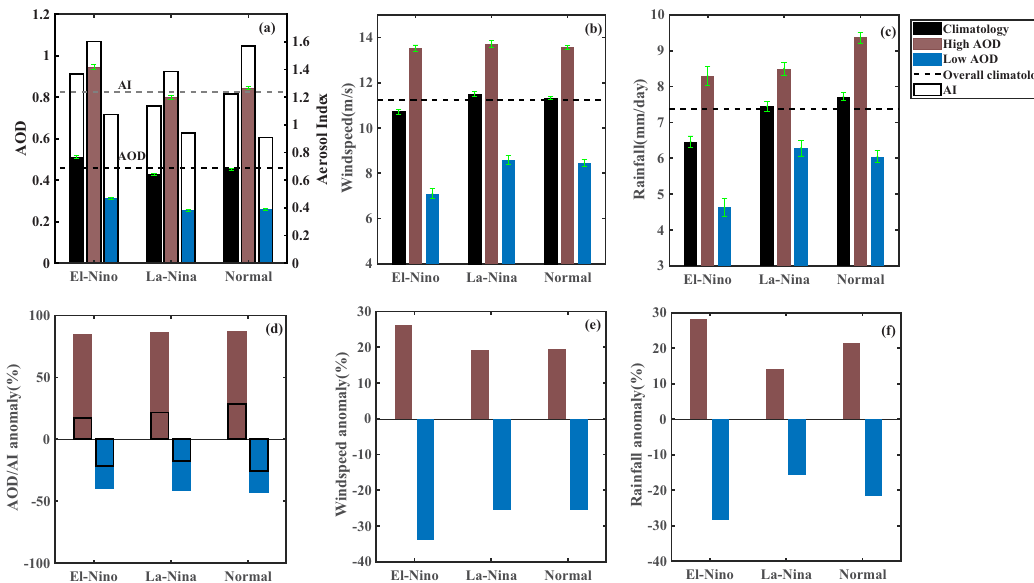
Fig. 3 Response of AOD/AI, winds over AS and rainfall over CI to high and low aerosol loading conditions over the AS. a Mean of AOD ( fi lled) and AI (un fi lled), b wind speed over AS, c rainfall over CI for the three phases of ENSO considering the climatology and the high/low aerosol loading conditions. d AOD/AI, e wind speed, f rainfall, anomalies in terms of percentage w.r.to the climatology of corresponding ENSO phase. The black dashed lines correspond to overall climatology considering all